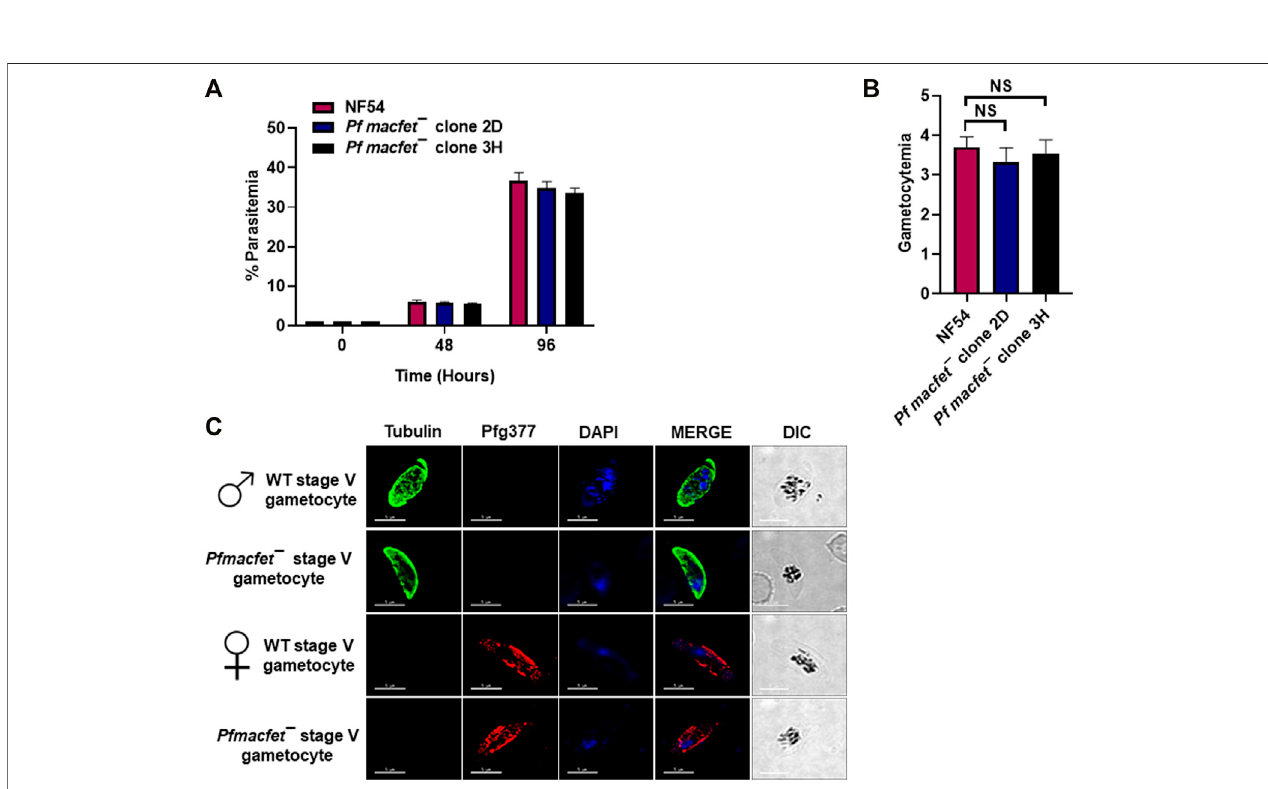
FIGURE 4 | Pfmacfet (cid:1) parasites grow normally as asexual parasites and undergo gametocytogenesis. (A) Pfmacfet (cid:1) (clone 2D and 3H) parasites grew at a similar rateasWT Pf NF54.Datawereaveragedfrom threebiologicalreplicatesand presented asthemean± standard deviation (SD). (B) Bar graph shows gametocytemia for WT Pf NF54 and Pfmacfet (cid:1) parasites (clone 2D and 3H) measured on day 15. Data were averaged from three biological replicates and presented as the mean ± standarddeviation(SD). (C) IFAsperformedonthinbloodculturesmearsforWT Pf NF54or Pfmacfet (cid:1) (clone3H)using α -tubulin(green),amale-speci fi cmarker, and Pf g377 (green), a marker for female gametocytes. Representative images are shown. DIC, differential interference contrast. DAPI, 4 ′ ,6-diamidino-2- phenylindole, Scale bar = 5 μ m.